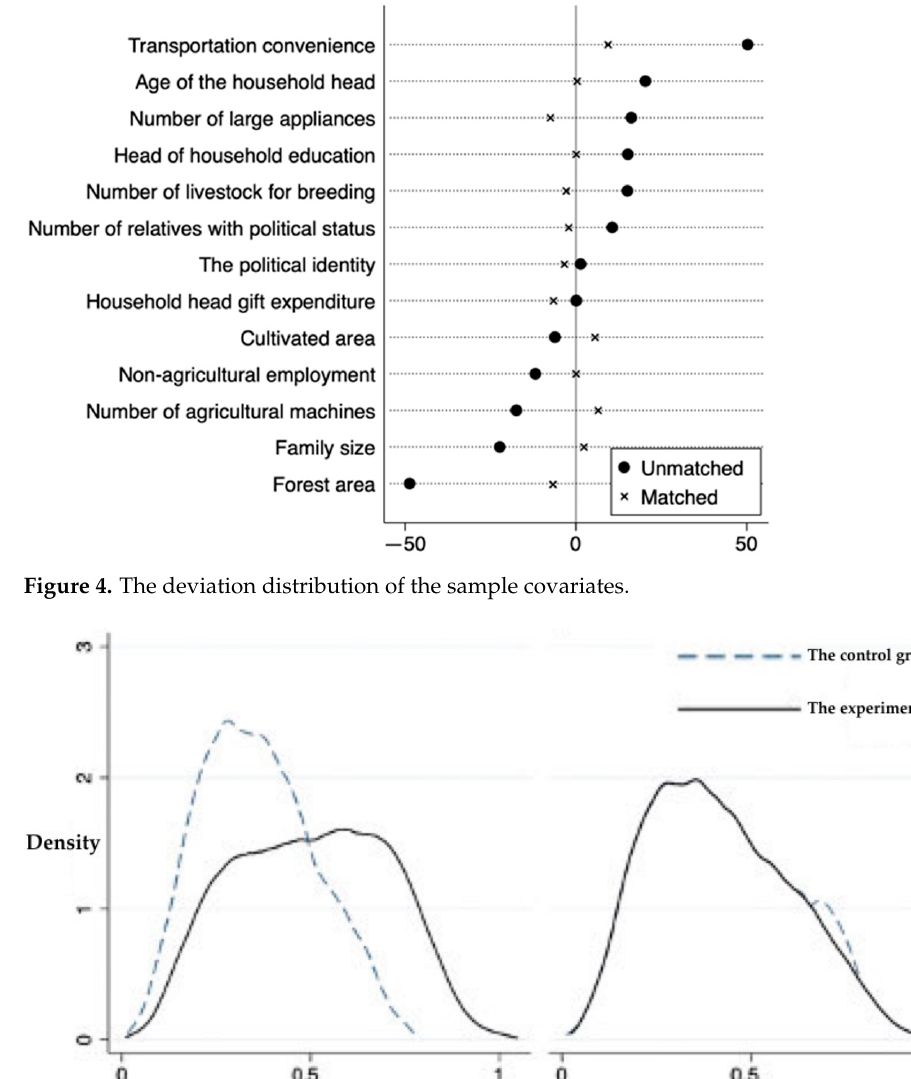
Table 5. Processing of the PSM method.